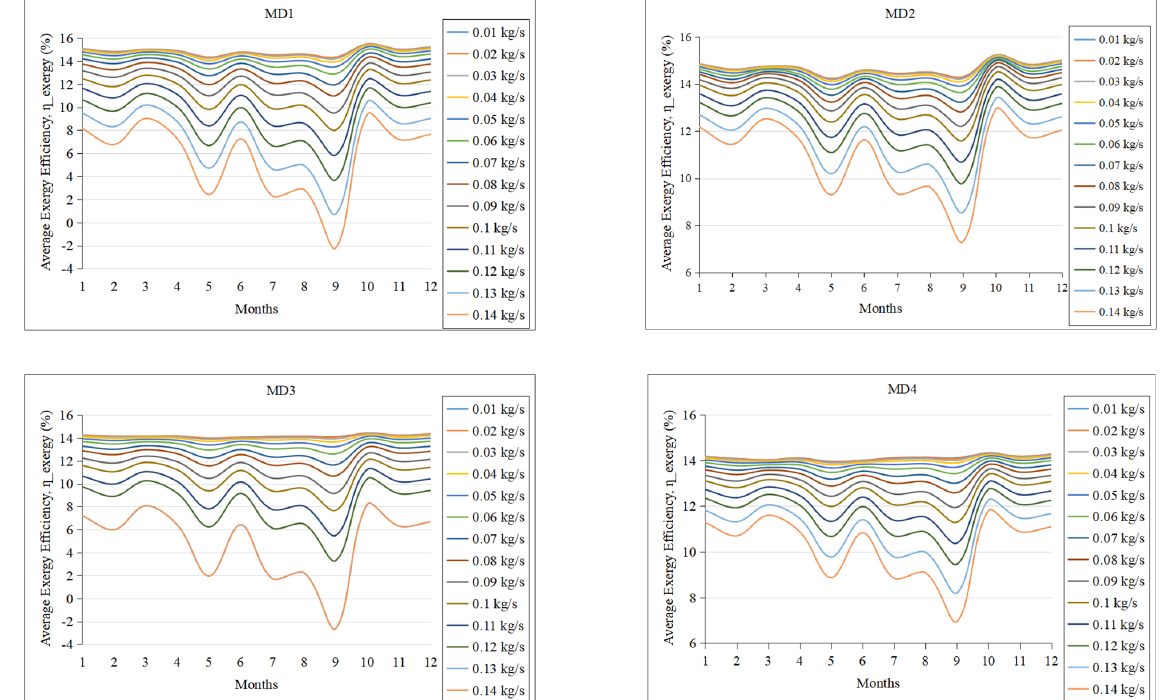
Figure 11. The average exergy efficiency of AWHS under flow change. After reaching maximum energy efficiency, AWHS has a decreasing energy effi- ciency with increasing water flow. This phenomenon occurs in all four models of the PV/T module. Further, it can be explained that, as the water flow increases, the pump power consumption ( P pump ) increases significantly because the pump runs at a fixed flow rate from 8 a.m. to 16 p.m. This greatly reduces P grid while Q hw has peaked (no change with increasing water flow). As a result, energy efficiency is reduced accordingly. Figure 10 also illustrates that the system has a high energy efficiency when using MD1 and MD2 compared to the other two models because MD1 and MD2 have an air layer between the glass and PV layer. The air layer creates a greenhouse effect, so it ab- sorbs more heat when the water temperature in the PV/T module is low (first stage). At the same time, the air layer acts as an insulation layer to reduce heat loss when the water temperature in the PV/T module is high (later stage). Figure 10 also shows that, with increasing water flow, the difference in energy effi- ciency in MD1 and MD3 is more pronounced than in the other two samples. The reason is that MD1 and MD3 use the Coil Tube (CT) heat exchanger while MD2 and MD4 use the Parallel Tube (PT). As the water flow increases, the pressure loss in the CT tube is much larger than that in the PT tube. So, P pump increases dramatically and causes P grid to drop rapidly. As a result, energy efficiency is reduced. Figure 11 indicates that AWHS has the highest average exergy efficiency in all months in the four PV/T modules when the flow rate reaches 0.02 kg/s. After reaching maximum exergy efficiency, the exergy efficiency of AWHS decreases as the water flow increases. Further, the exergy efficiency at flow rate 0.14 kg/s is significantly lower than other flow rates. Similar to the explanation above, because at the flow rate of 0.14 kg/s, the pump’s power consumption is quite large because the pump runs at a fixed flow rate during the survey period., especially with MD1 and MD3 with a long pipeline, large pres- sure loss, which greatly reduces P grid .